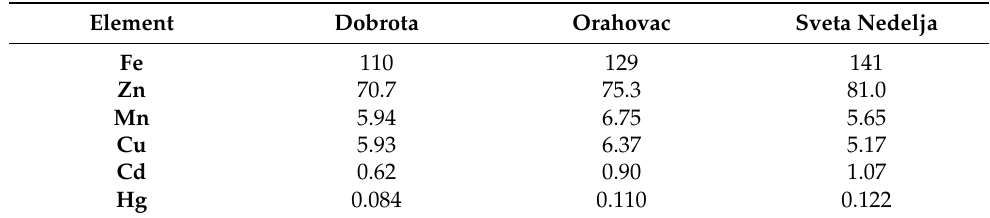
Table 2. Trace metal concentrations (mg/kg dw) found in mussels Mytilus galloprovincialis at three locations from Boka Kotorska